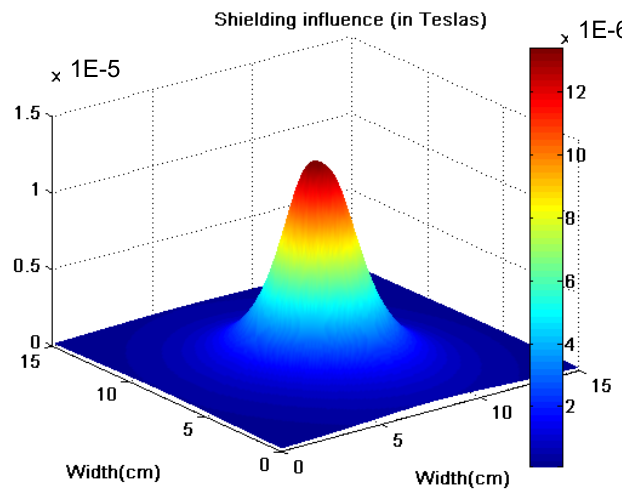
Figure 7. Shielding influence repartition.